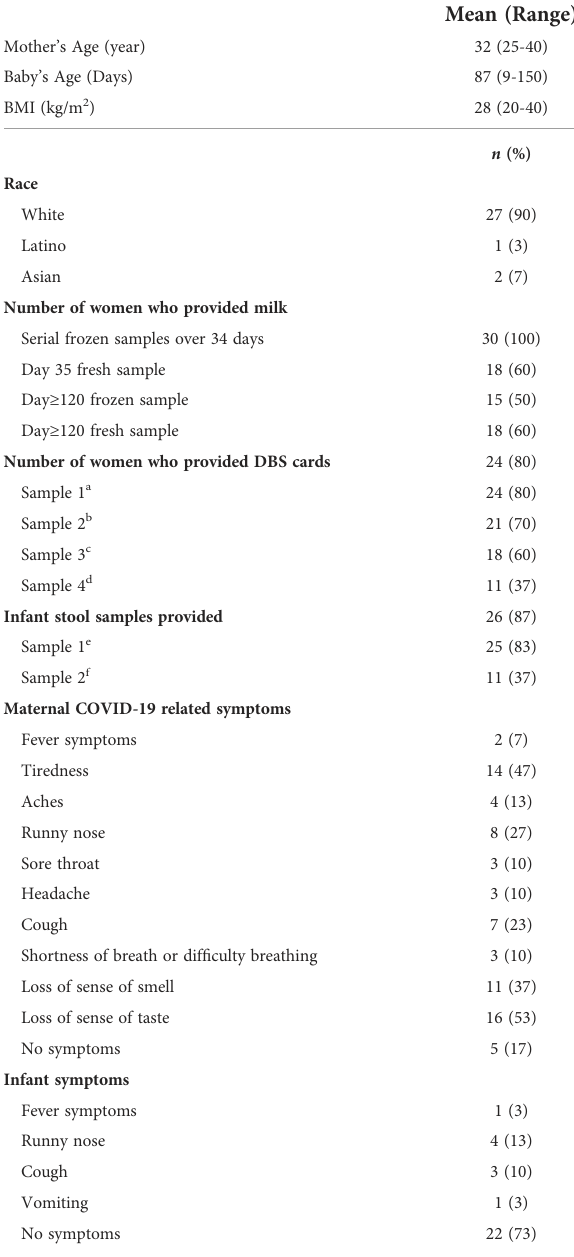
TABLE 1 Participant demographics and COVID-19 related information ( n =